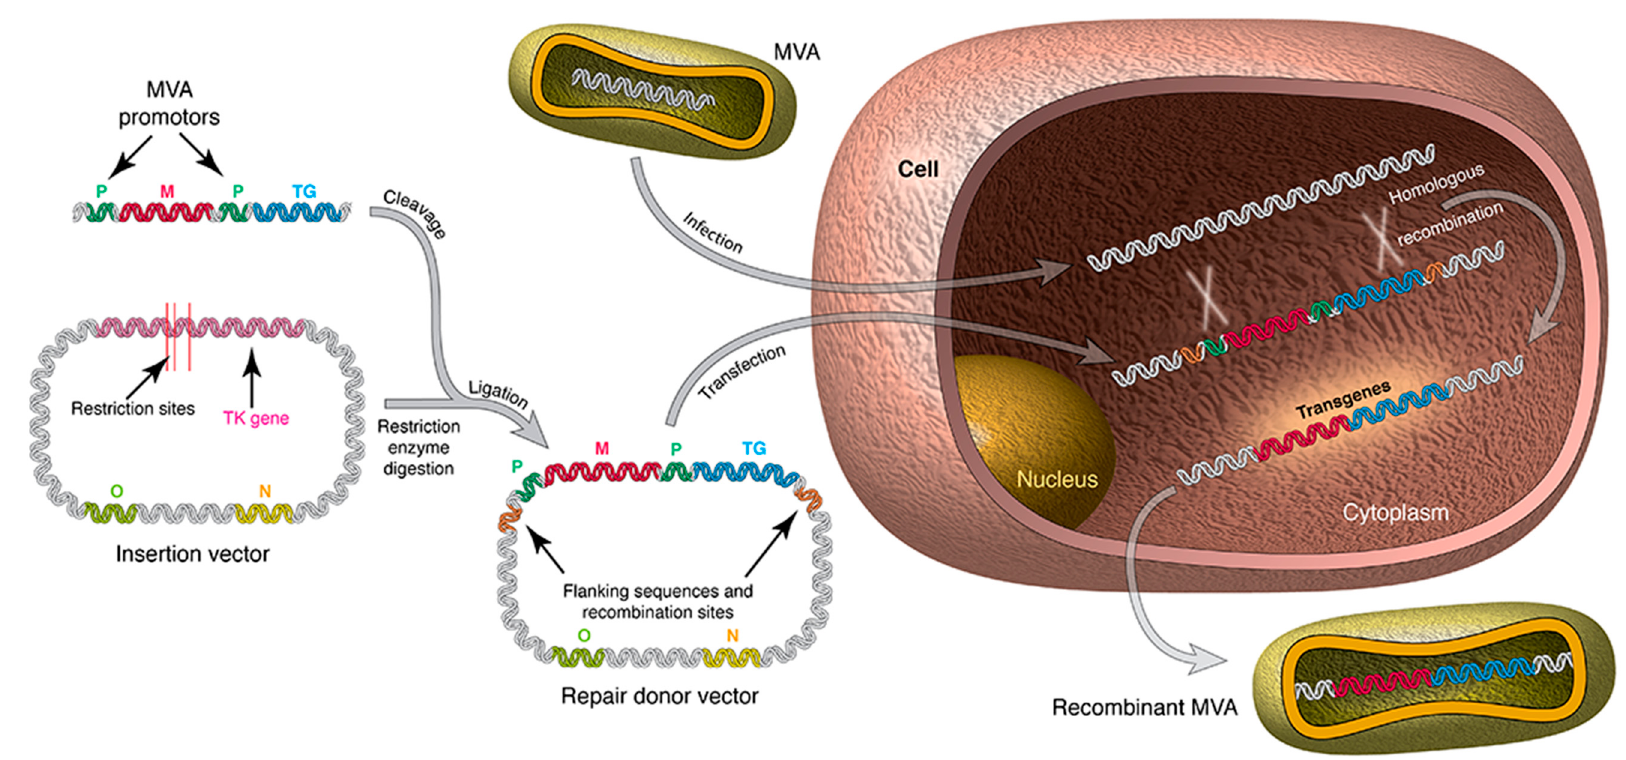
Figure 1. Construction of recombinant MVA vector by homologous recombination. A plasmid that contains the gene or transgene of interest is constructed and used to transfect an MVA-infected cell. TK - Recombinant MVA vectors are produced by homologous recombination; TK: thymidine kinase gene; M: marker gene; TG: foreign gene; P: promoter; O: Origin of plasmid replication; N: Marker gene for plasmid selection.